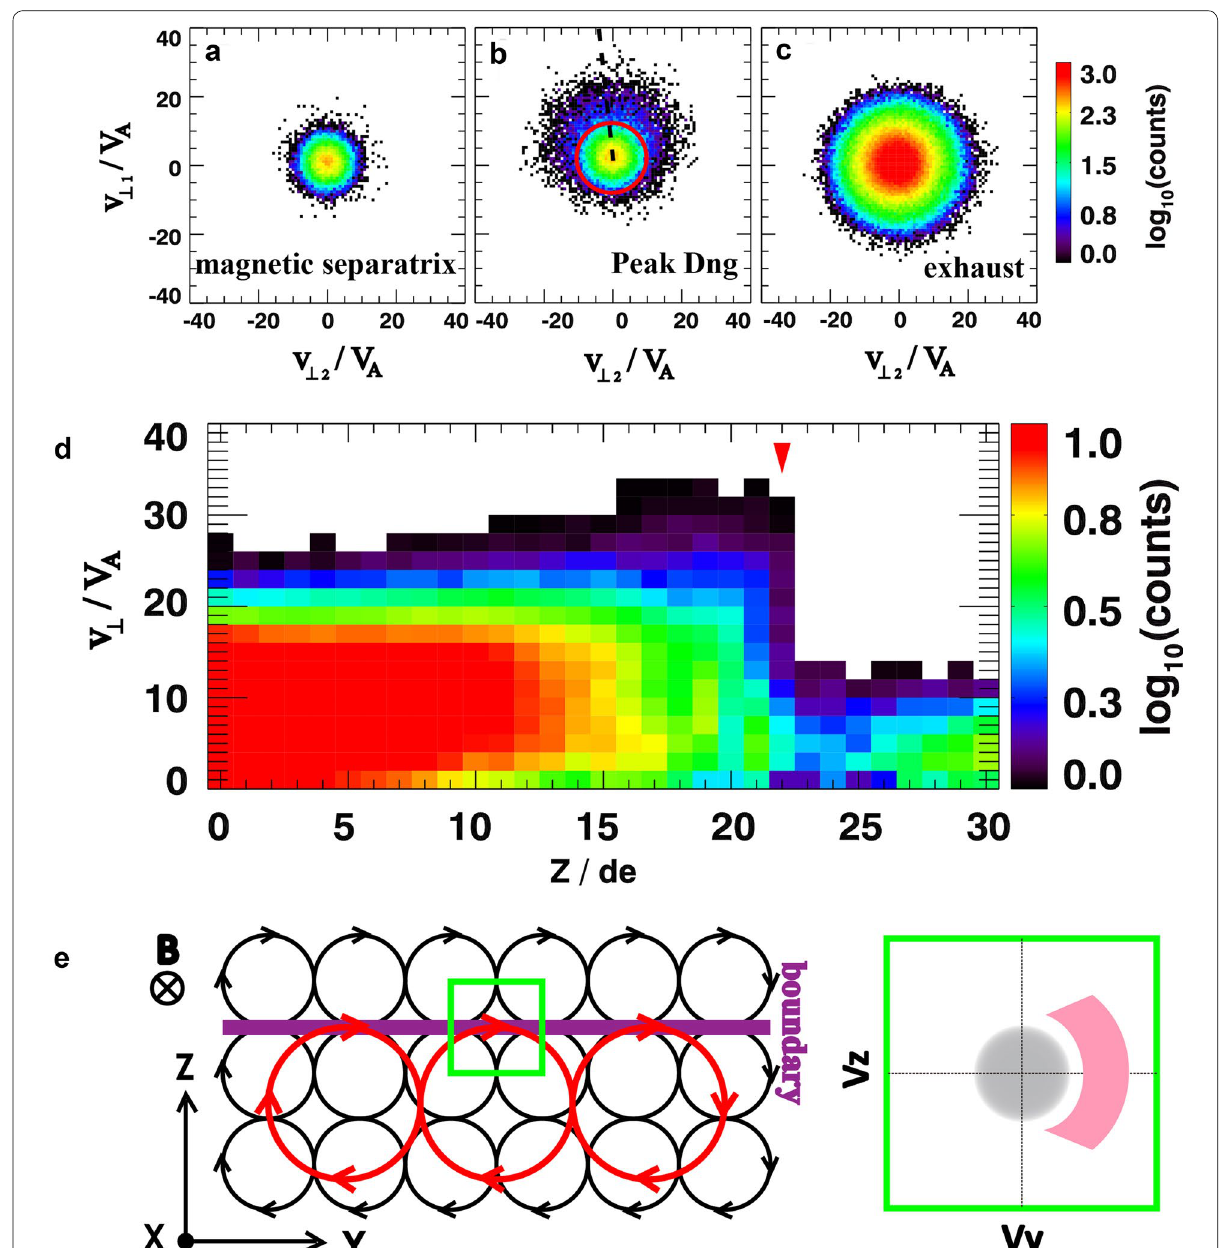
Fig. 2 Electron distributions on the electron separatrix. a – c Electron velocity distribution functions (eVDFs) in the plane perpendicular to the field lines. The locations to get the eVDFs are marked in Fig. 1a, b by small white rectangles . d electron spectra within the pitch-angles of [80°, 100°], cal- culated at the white vertical line in Fig. 1a. The red inverted triangle marks the position of the peak D ng . The electron spectra show that the maximum perpendicular energy drops sharply at the enhanced D ng region, implying that the enhanced D ng region marks the boundaries for the energetic electrons accelerated in the diffusion region. e Sketch map for the generation of nongyrotropy due to the finite gyroradius effect. The black circles with arrows present low-energy electrons. The red circles with arrows present accelerated electrons. The thick purple line is the boundary of the accelerated electrons, which presents the electron separatrix. The right plot is the relevant eVDF calculated on the electron separatrix in the region represented by the green box stretched across the boundary. The gray population in the eVDF is composed of low-energy electrons, while the pink nongyrotropic population is composed of the accelerated